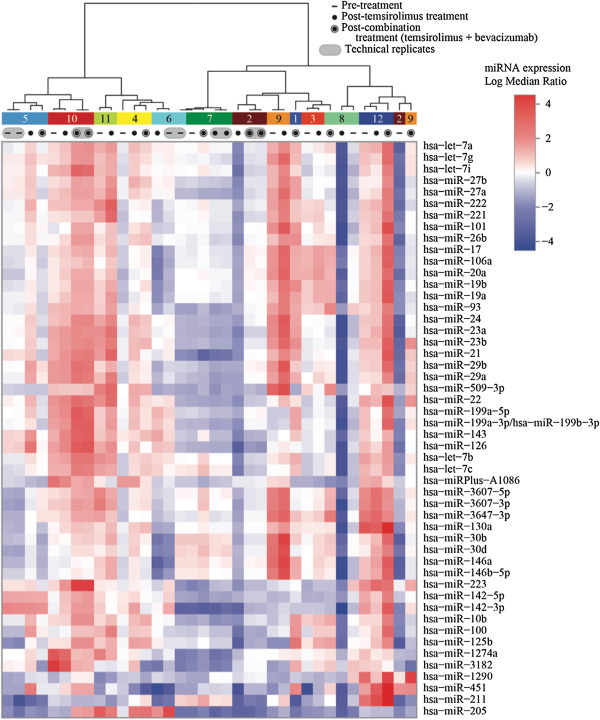
Unsupervised clustering analysis of miRNA expression. The heat map illustrates the result of the two-way hierarchical clustering of miRNAs and samples. Each row represents one miRNA and each column represents one sample, including pre-treatment, post-Temsirolimus alone, or post-combination treatment samples from patients #1 through 12. Samples resubmitted for quality assurance purposes are marked by a shaded oval enclosing the duplicate samples. The color scale illustrates the relative expression level (log median ratio, LMR) of a miRNA across all samples: red color represents an expression level above the mean, blue color represents expression lower than the mean. Clustering was performed on all samples and on the 50 miRNAs with the highest standard deviation across the sample set.